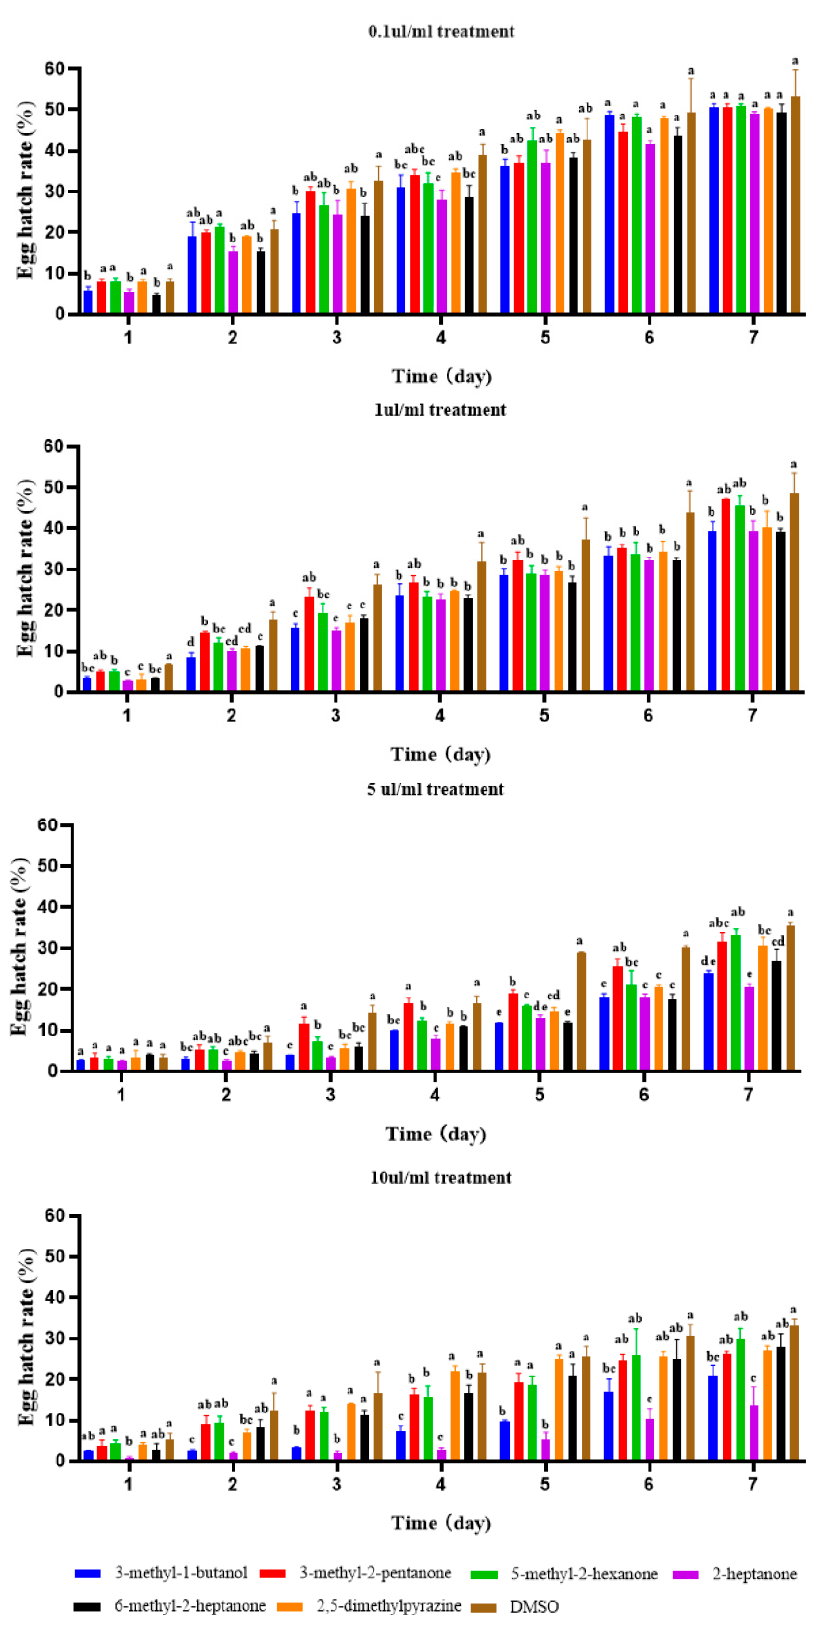
Figure 5. Impact of fumigation by six VOCs at different concentrations on egg hatching of root-knot nematodes after 1, 2, 3, 4, 5, 6, and 7 days of incubation. Different lowercase letters indicate significant differences among treatments ( p < 0.05); bars indicate the standard error of the means ( n = 3).